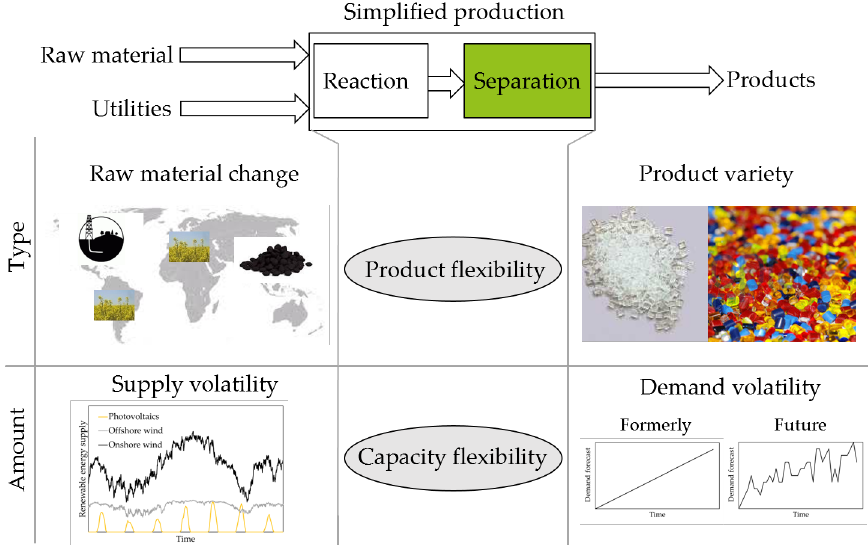
Figure 1. Motivation for flexible production shown by means of flexibility types and uncertainties a ff ecting the production